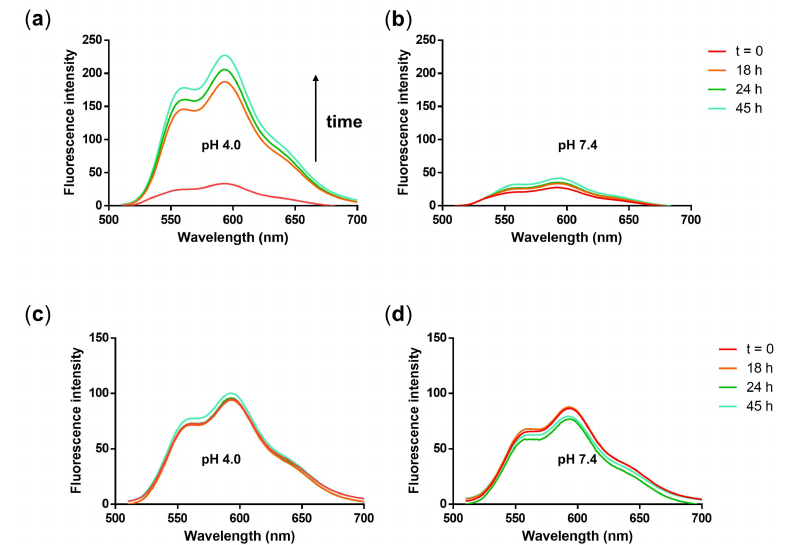
Figure 8. Fluorescence emission spectra of NG3 after incubation in ( a ) acetate buffer (pH 4.0, 50 mM) and ( b ) phosphate buffer (pH 7.4, 50 mM) at 37 ◦ C over 45 h. Fluorescence emission spectra of non-cleavable PG-DOX(non) NG after incubation in ( c ) acetate buffer (pH 4.0, 50 mM), and ( d ) phosphate buffer (pH 7.4, 50 mM) at 37 ◦ C over 45